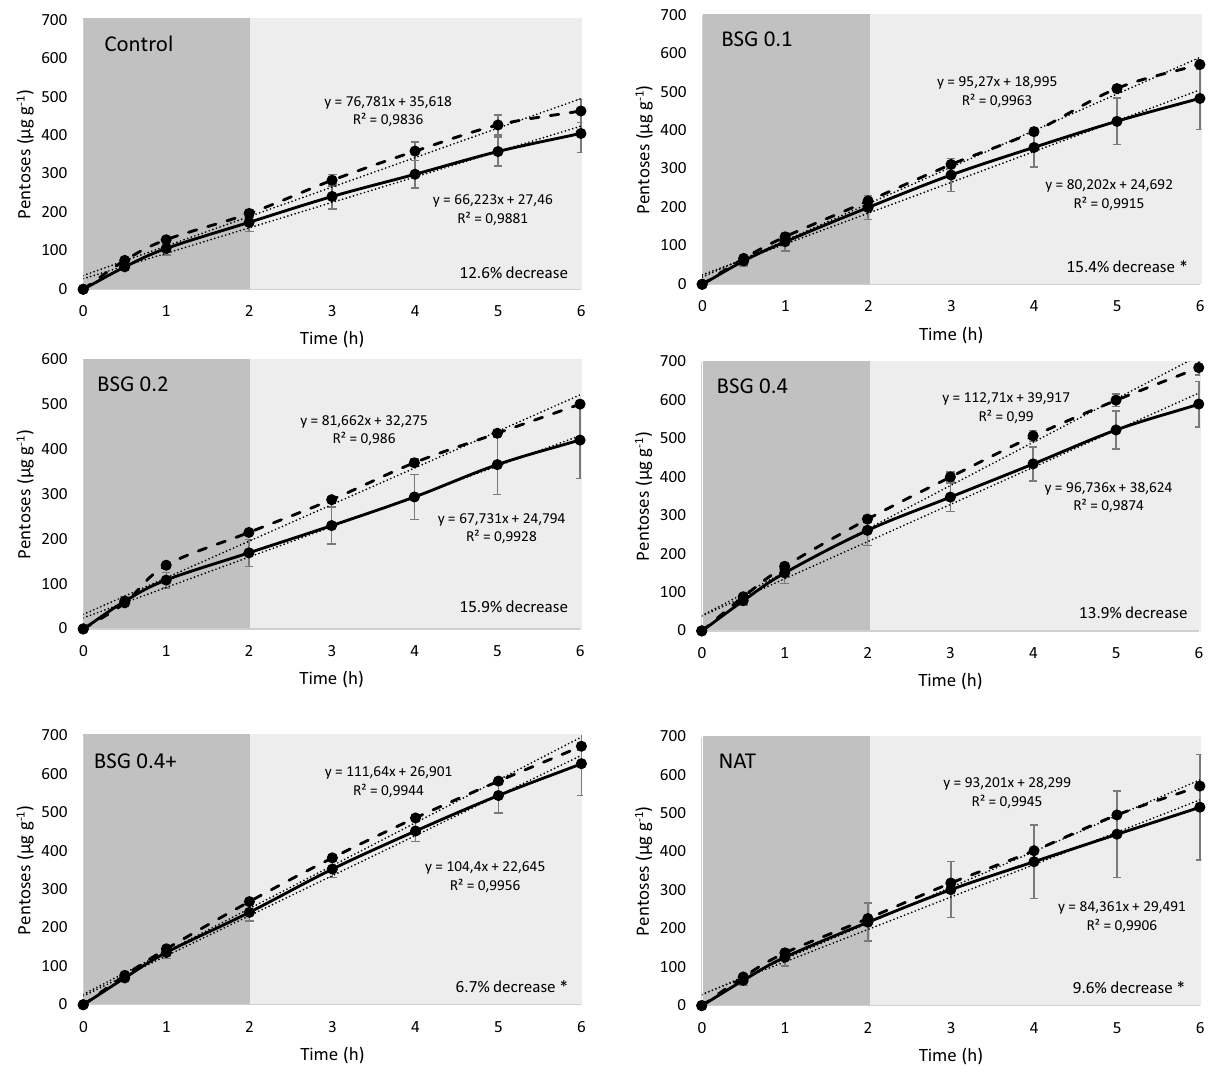
Figure 4. Pentoses release (mg g −1 of diet) from the different experimental diets under the simulated conditions of the European seabass digestive tract with active (continuous line) and inactive fish enzymes (dashed line). The slope of linear fitting provides the rate of release of pentoses per hour (mg g −1 of diet h −1 ). Stomach and intestinal digestions are represented in dark and light grey, respectively. Values expressed as mean ± standard deviation. Asterisks indicate significant differences between active and inactive fish enzymes ( p <